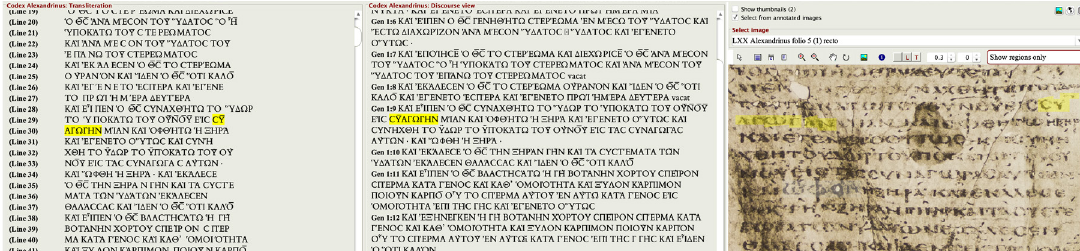
Figure 17: Digital image of Greek codex (Alexandrinus) with hot-spot. The left pane shows the transcription arranged by